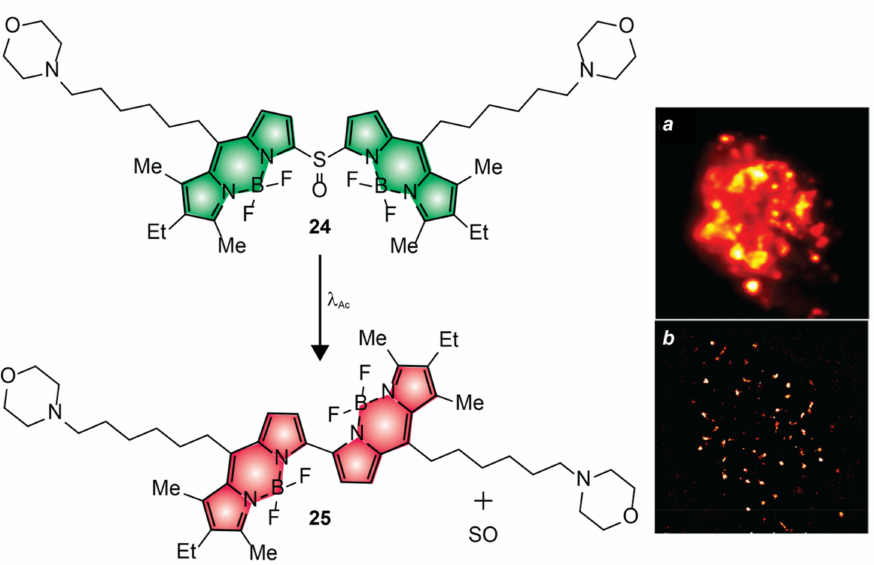
Figure 13. Diffraction-limited ( a ) and PALM ( b ) images of the lysosomes of live RAW264.7 cells labeled with 24 [adapted with permission from Ref.